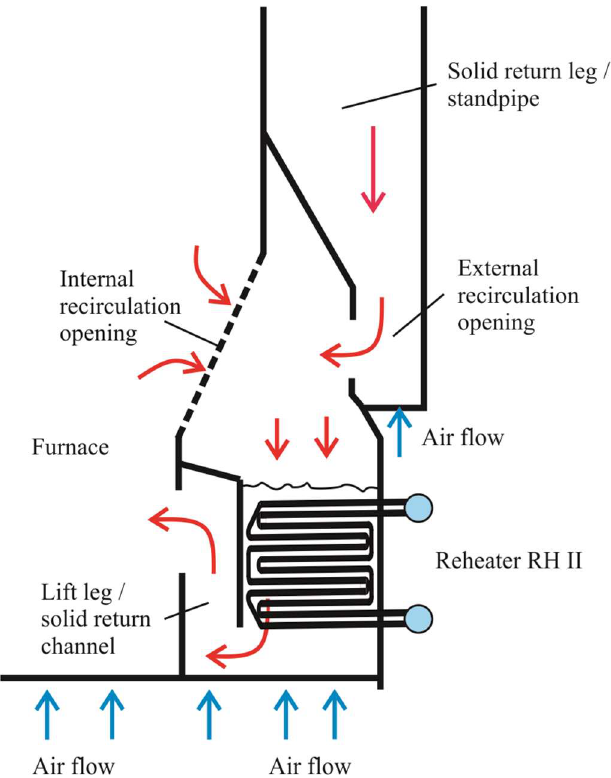
Figure 5. The schematic layout of the fluidized bed heat exchanger Intrex tm RH II in a 1296 t/h CFB boiler. Table 5. Tube bundle